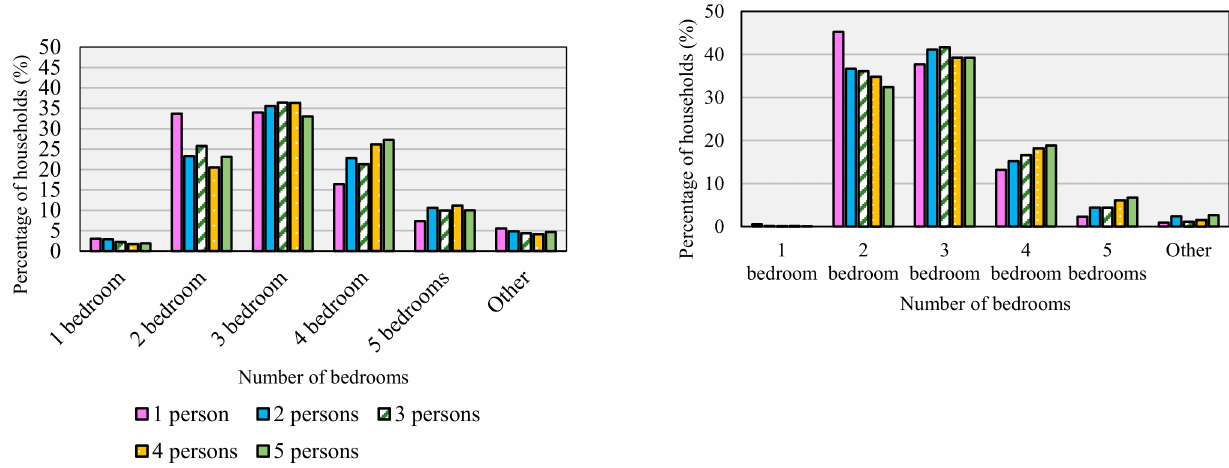
Figure 21. Percentage of household size with type of unit apartments in 2012 vs. 2018 in Iran.